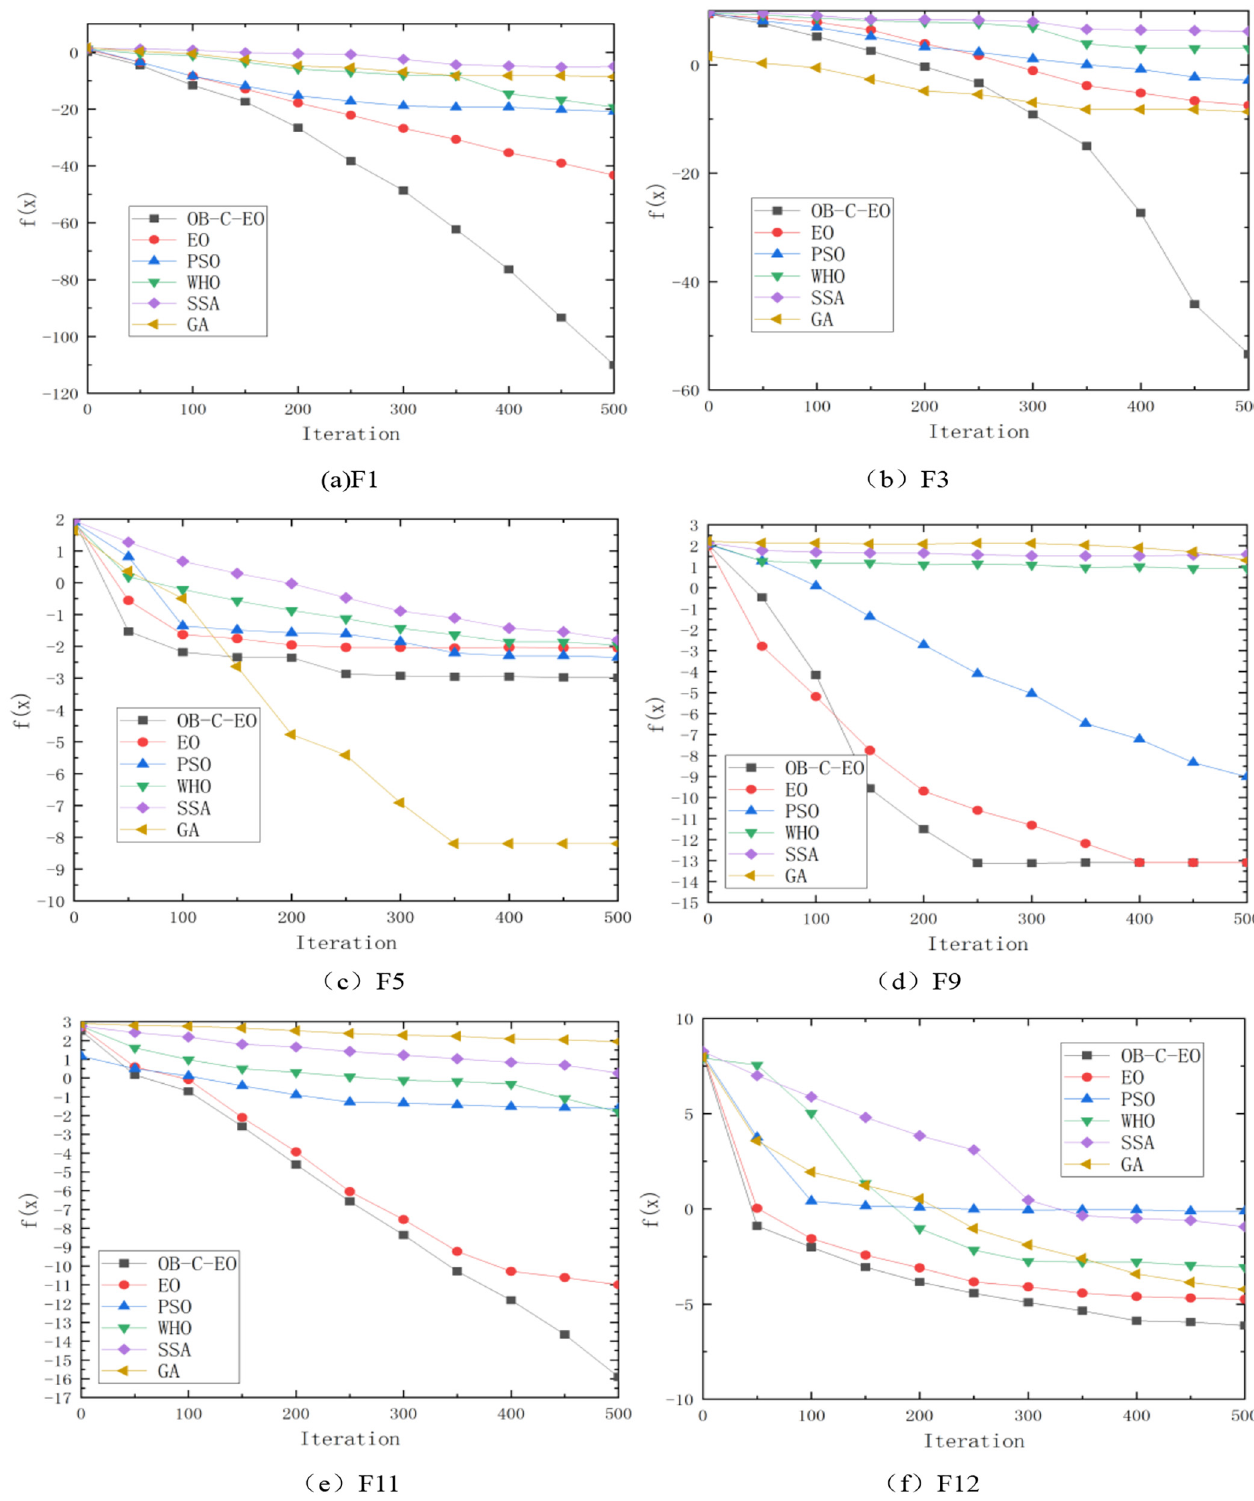
Fig. 8. Average convergence